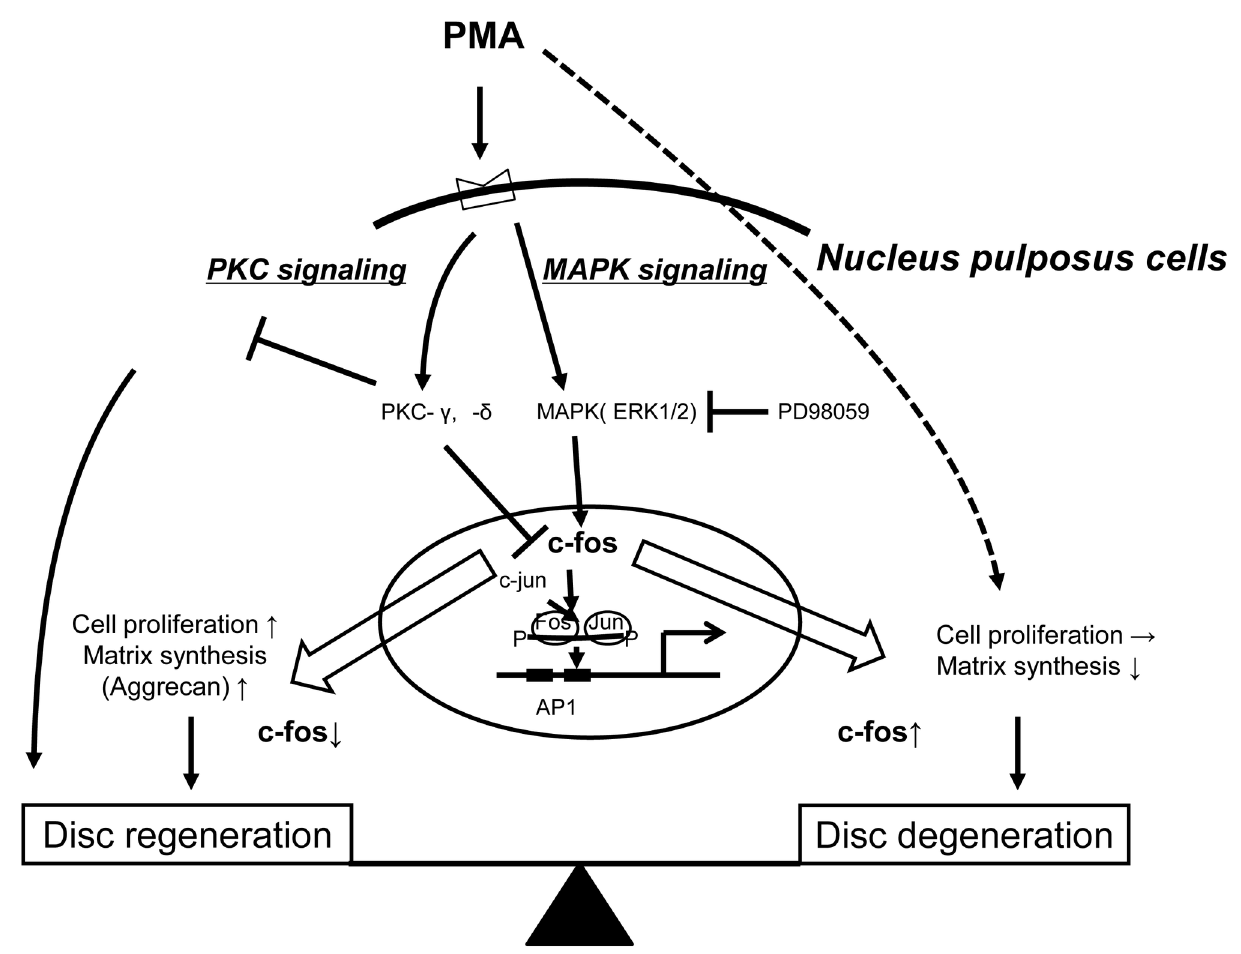
Figure 7. Proposed model for the regulation of c-fos expression by PKC signaling and MAPK signaling in NP cells. doi: